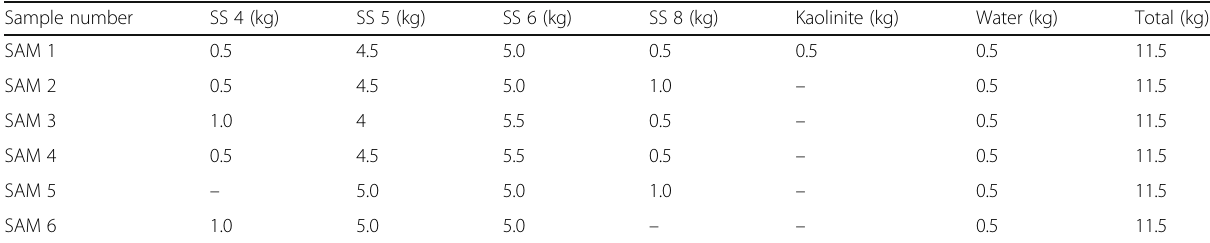
Table 1 Silica sands and kaolinite mixed ratio of samples